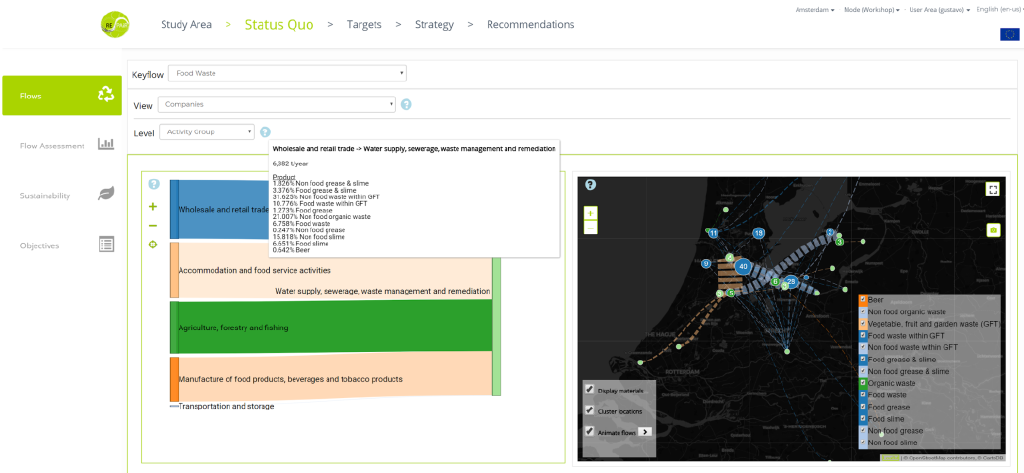
Figure 12. Stakeholders used the GDSE to explore the area’s status quo by visualizing flows per activity group as seen in the Sankey diagram (left) and as a flow map (right) of existing related food waste streams (grouped by materials) deemed relevant by the stakeholder during the workshop. Both visualizations are linked, i.e., each Sankey flow correspond to one or more flows on the map. Material flow composition is shown on each Sankey flow (left) and on color-coded on the map